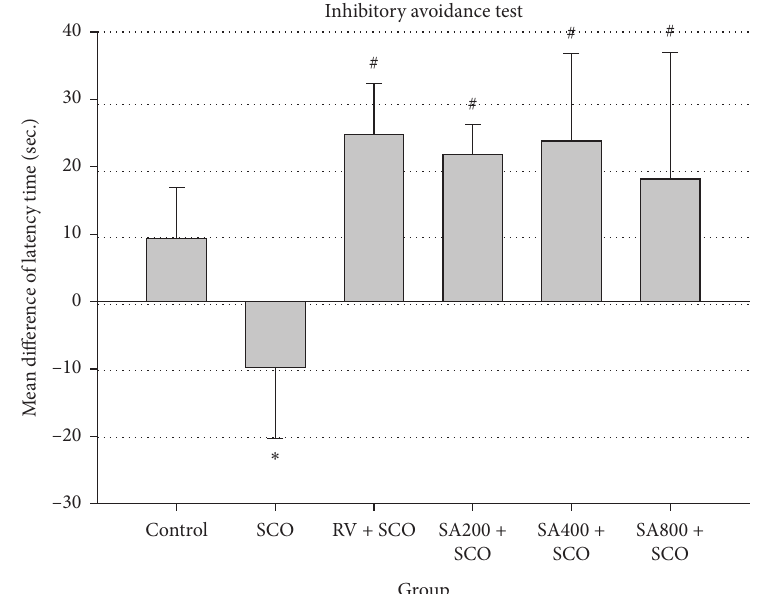
Figure 4: Effect of SCO, RV, and SA extract on the inhibitory avoidance test. Mean difference of latency time in inhibitory avoidance test expressed as mean ± SEM. ∗ p value < 0.05 compared to the control group, # p value < 0.05 compared to the SCO group.